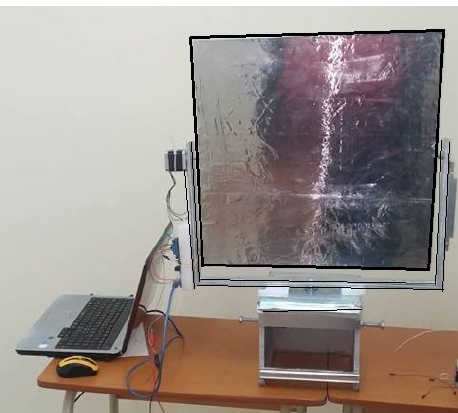
Fig. 7. The initial design of our prototype